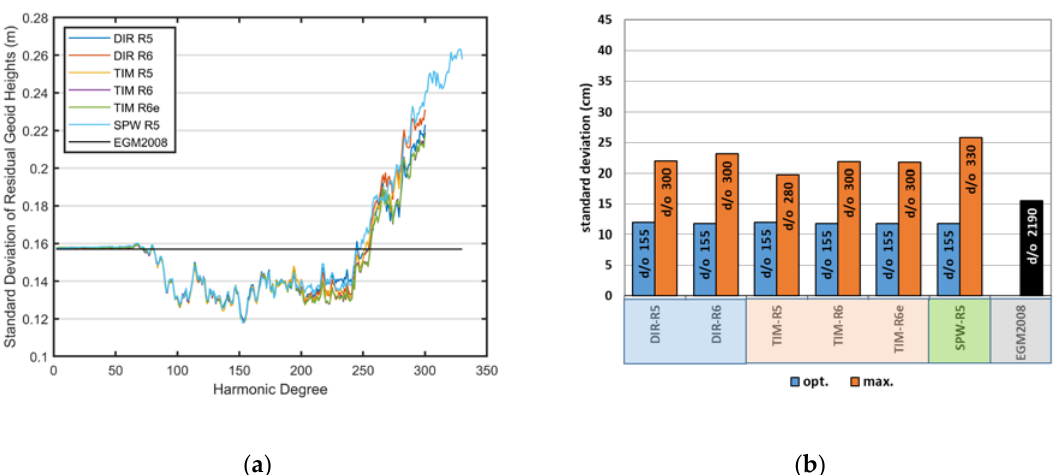
Figure 7. Comparison of RL5 and RL6 models: ( a ) the standard deviations of the geoid undulation residuals ( N GPS / lev . − N enh . ) in meters (Dataset II), ( b ) the standard deviations of geoid undulations in cm, and please note that the geoid heights ( N enh . ), derived from the enhanced GGMs over the optimum (blue bar) and the maximum (orange bar) degrees of the models.